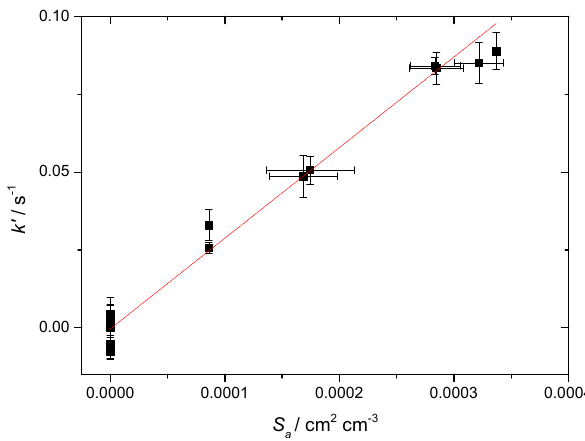
Figure 3. First-order rate coefficient for loss of HO 2 due to hetero- geneous reaction with TiO 2 particles at different total surface ar- eas for T = 296K and RH = 37%. The gradient yielded a value of γ (HO 2 ) = (2.68 ± 0.01) × 10 − 2 , with the uncertainty representing 2 σ random errors from the fit (95% confidence limits).